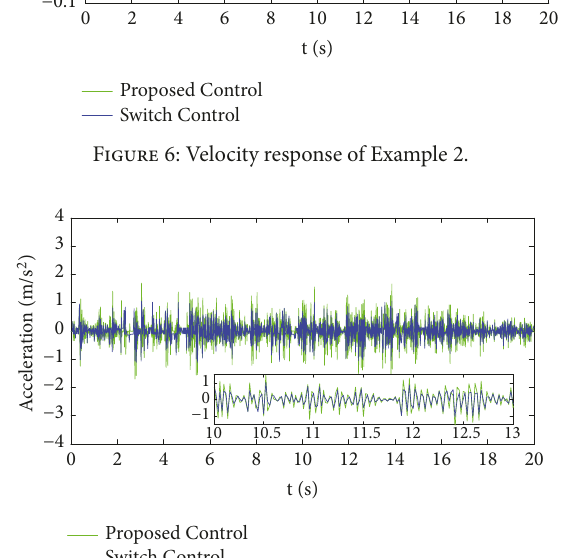
Figure 7: Acceleration response of Example 2.